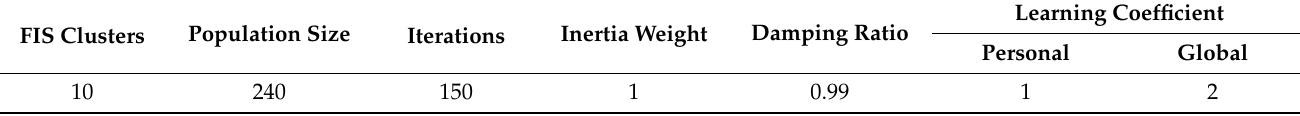
Table 6. Parameter characteristics used for PSO.